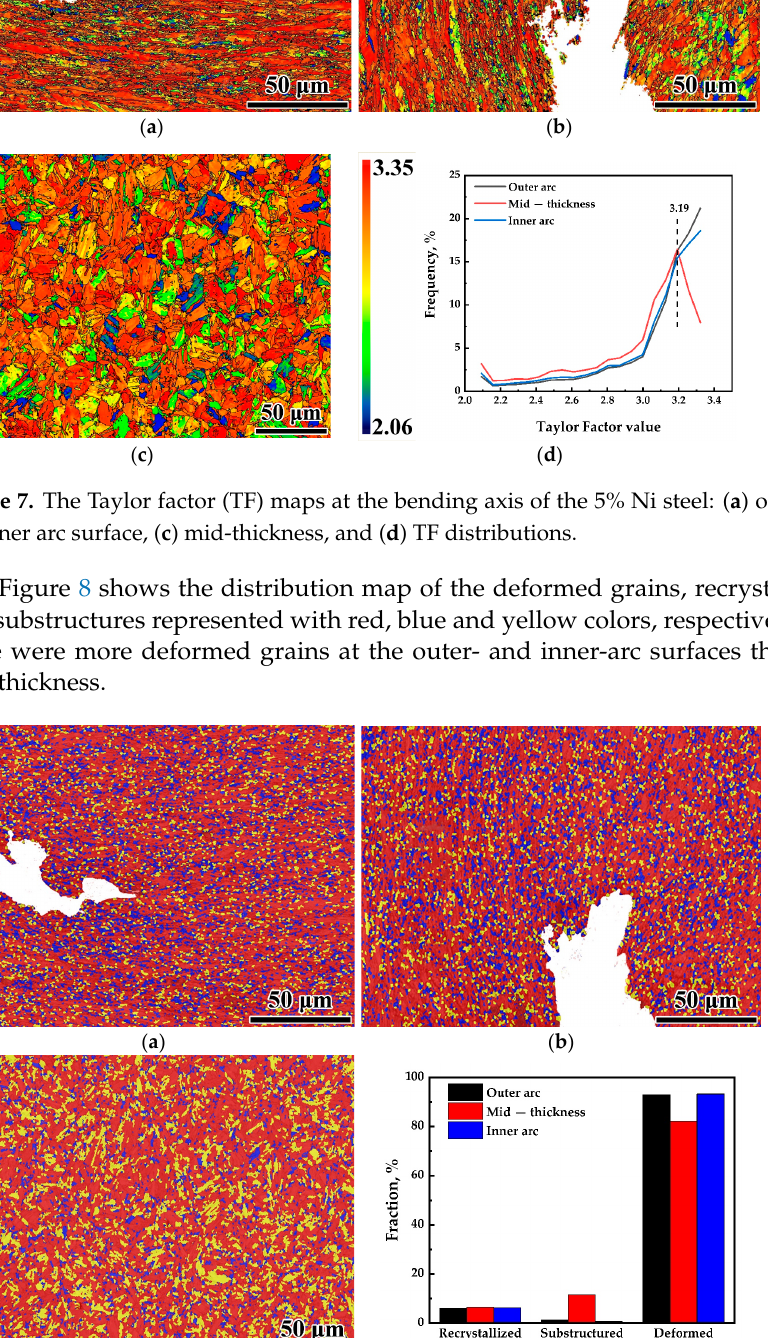
Figure 8. The distribution map of the deformed grains, recrystallized grains, and substructures of the 5% Ni steel sample: ( a ) outer arc surface, ( b ) inner arc surface, ( c ) mid-thickness, and ( d ) volume fractions of recrystallized, substructured, and deformed regions. The kernel average misorientation (KAM) maps at the bending axis are shown in Figure 9. The KAM distribution reflects the local strain gradient by the orientation gradi- ent and hence the underlying distributions of the lattice defects. The KAM values (degree) were calculated up to 5°. The color ranged from blue to red, indicating that the value of the local strain distribution changed from small to large. According to Morsdorf et al. [24],